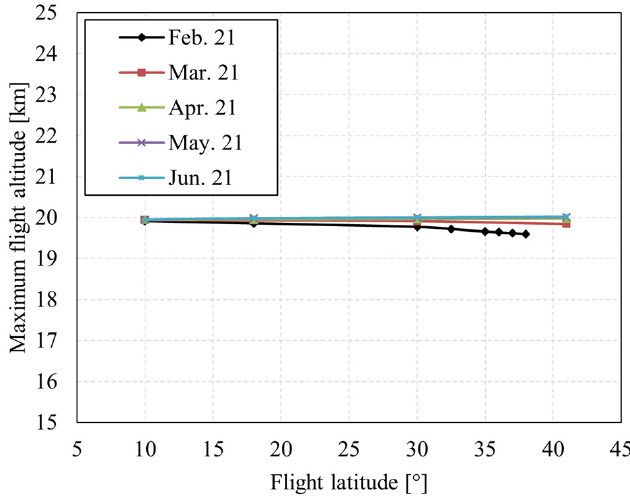
Figure 31. Comparison of PV cell output power at different latitudes (Apr. 21).